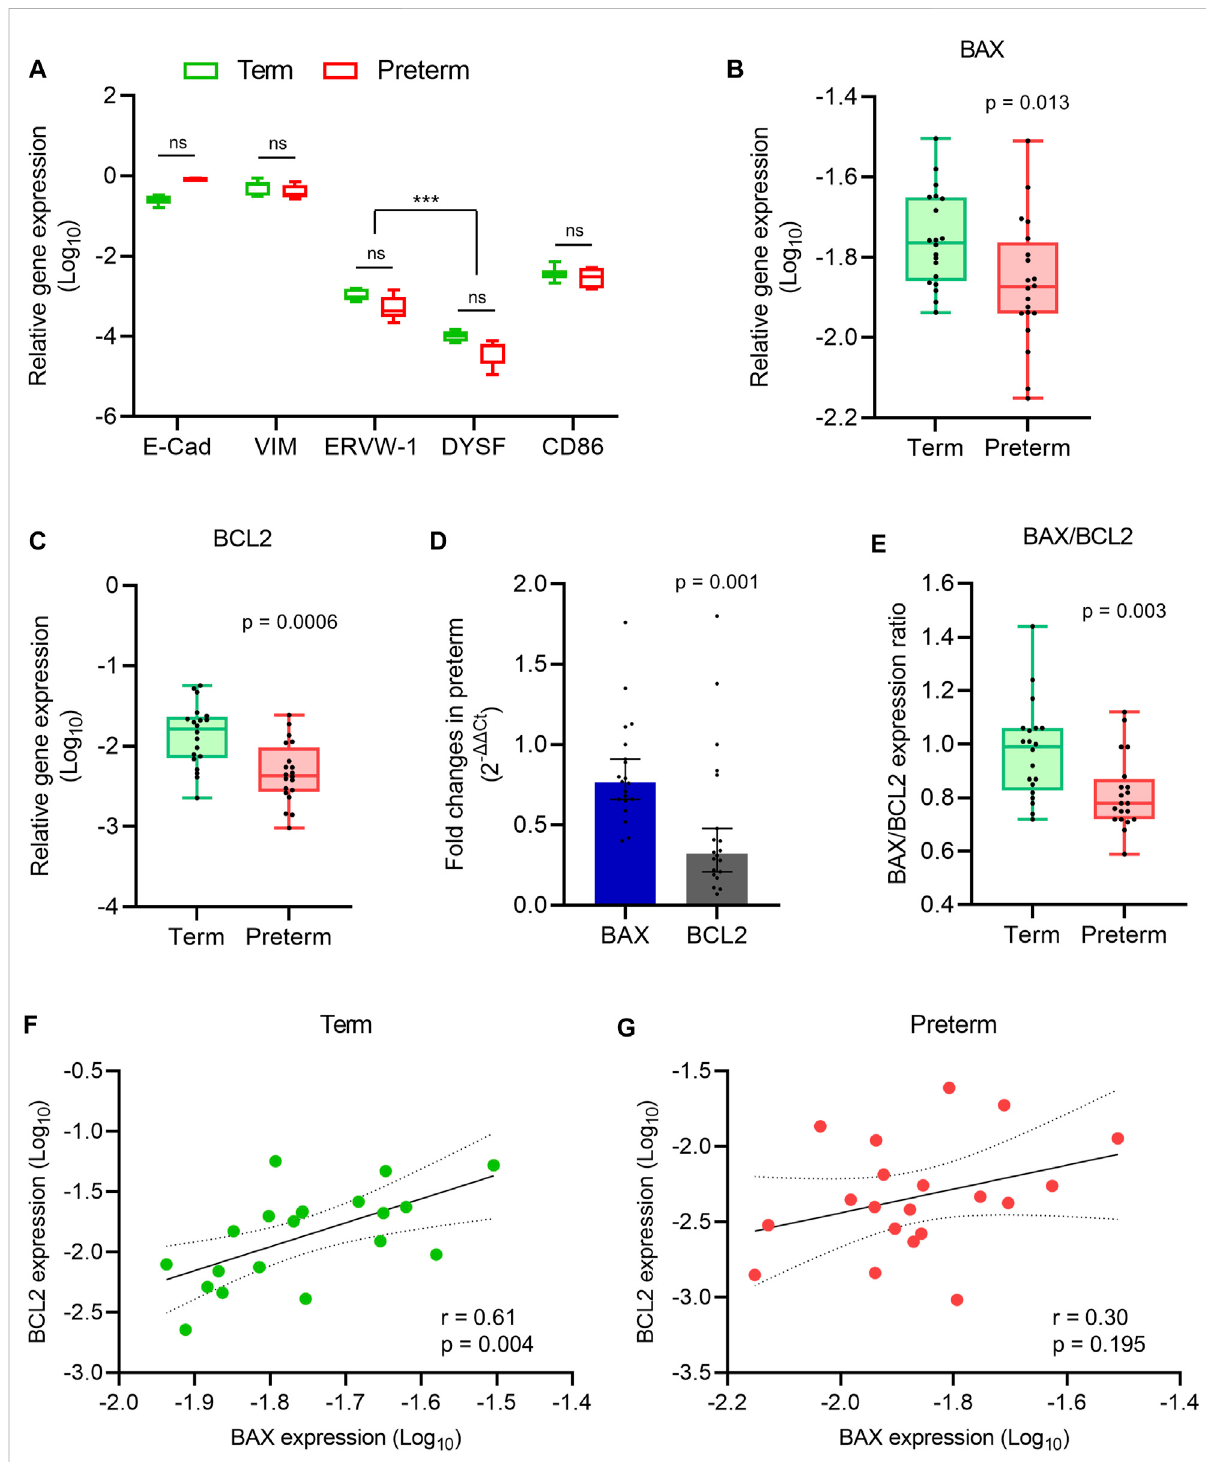
FIGURE 1 Apoptosis gene expression analysis. (A) Box plot of qRT-PCR analysis showing various cell-speci fi c gene expressions (relative to GAPDH ) in villous tissue of term and preterm placentas (n = 6 term and six preterm); *** p < 0.001; Two-way ANOVA with Tukey ’ s post hoc analysis. (B,C) Box plots of qRT-PCR analysis showing gene expression (relative to GAPDH ) of BAX (B) and BCL2 (C) in term and preterm placentas. (D) Fold-changes (Relative toterm,2 - ΔΔ Ct )inthe BAX and BCL2 geneexpression inpreterm placentacompared totermplacenta. (E) Ratiobetween BAX and BCL2 geneexpressionintermandpretermplacentas. (F,G) SpearmanRanktestcorrelationanalysisbetween BAX and BCL2 geneexpressionintheterm (F) and preterm (G) placentas. Dotted lines represent 95% CI bands of the best- fi t lines (Solid). n = 20 term and 20 preterm (B – G) ; ns = not signi fi cant. Mann-Whitney U test (B – E) . Box plots data are presented as median and interquartile ranges (IQR) with minima and maxima. Each dot indicates an individual subject (B – G)